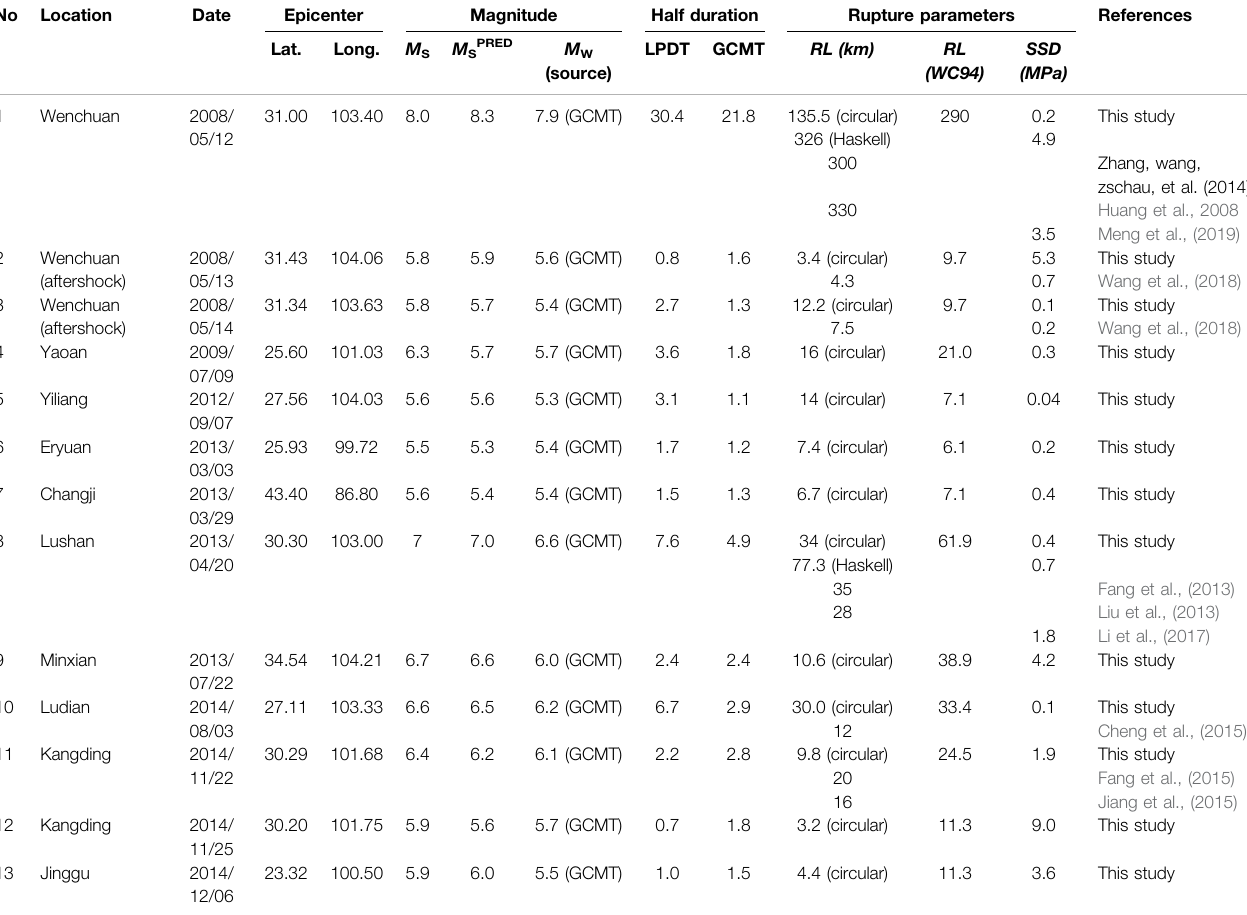
TABLE 1 | List of source parameters including catalog magnitude (Ms), predicted magnitude (Ms PRED ), half duration, Rupture length (RL) and stress drop ( Δσ ) determined in this study for moderate-larger events ( M ≥ 5.5). No